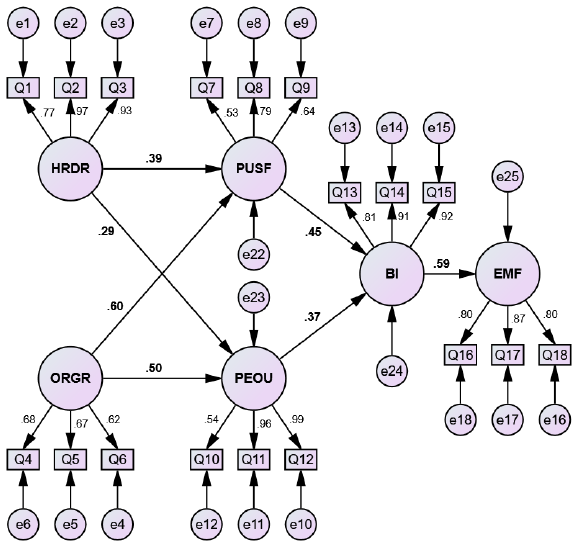
Fig. 3. Research structural